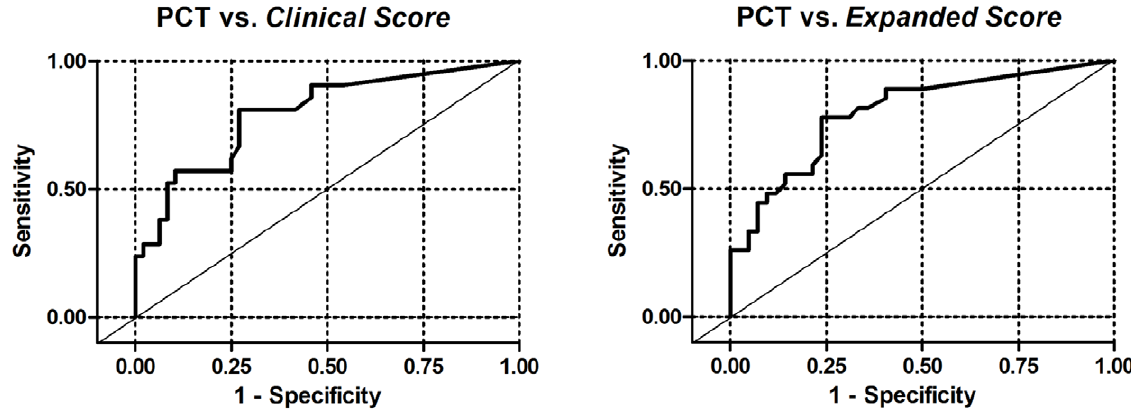
Figure 4. ROC curves of PCT vs. the ClinicalScore and the ExpandedScore . The area under the curve for both is 0.8.